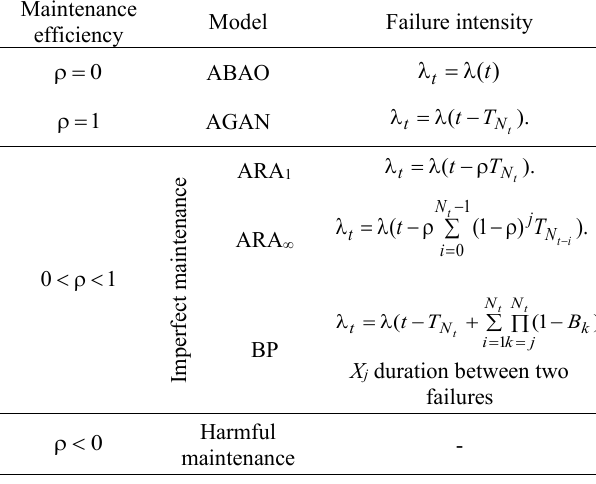
Table 1. Failure intensity associated with maintenance